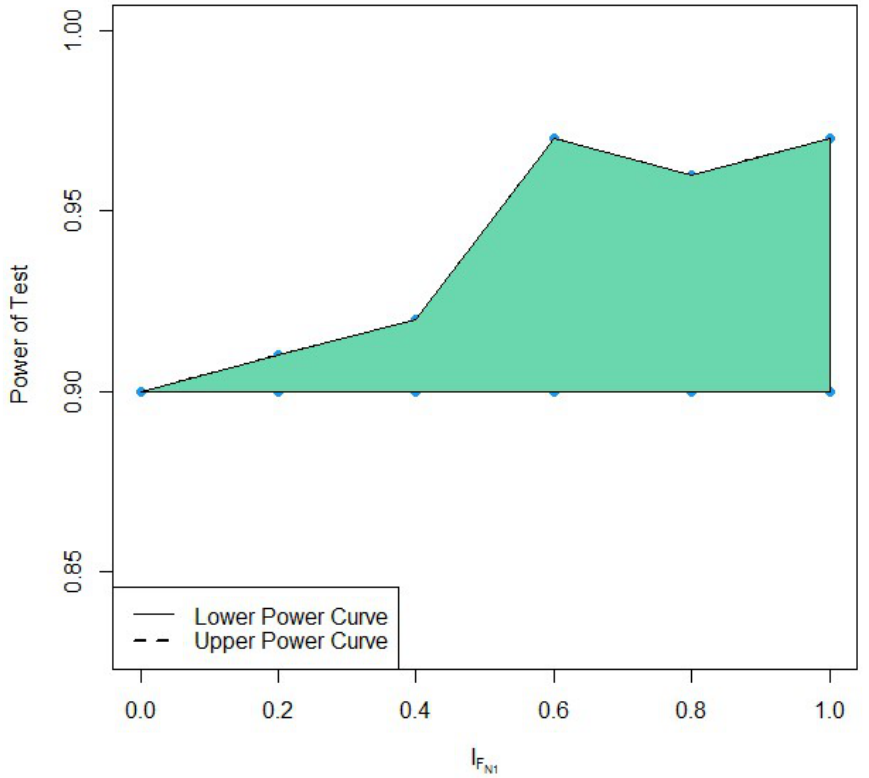
Figure 1. The curve of the power of the test when 𝛼 = 0.05.